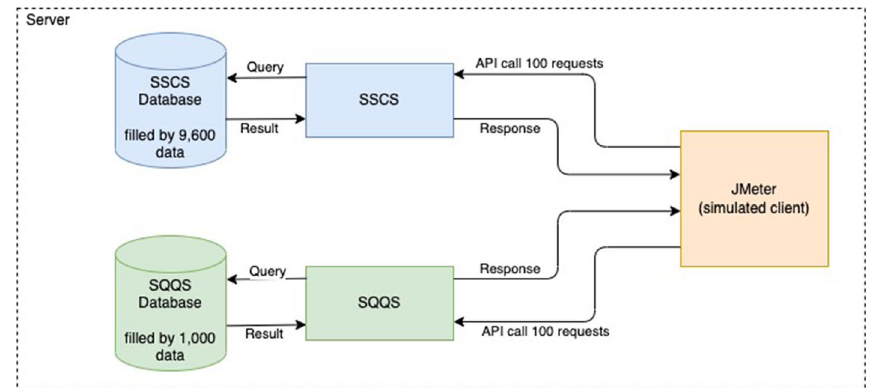
Fig. 5 Database read evaluation topology on the traditional system